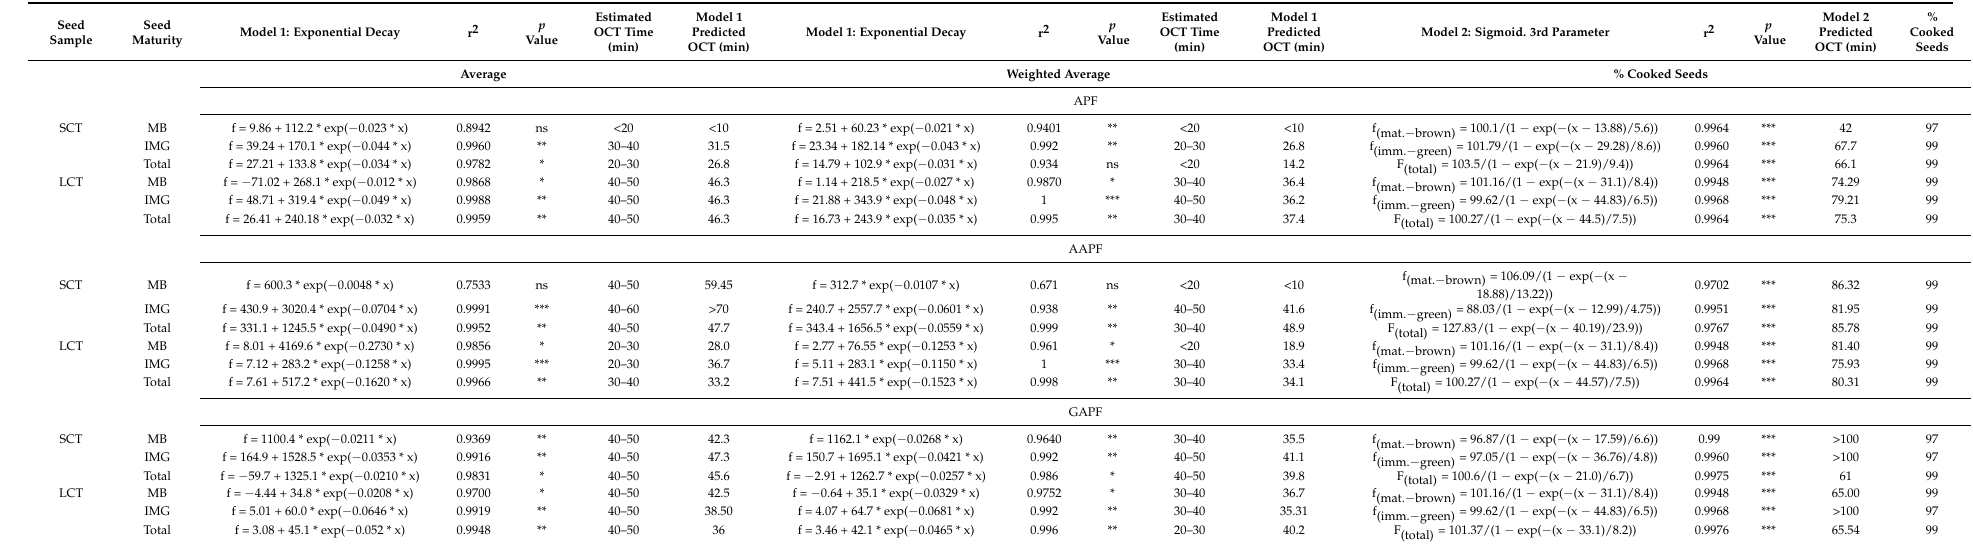
Table 4. Estimated range and predicted OCT based on the average and weighted average using the exponential decay model or based on the percentage of cooked seeds using the sigmoid model of MB, IMG, or total lentil seed samples (easy to cook—SCT, and hard to cook—LCT) for APF (absolute positive force), AAPF (area to absolute positive force), and GAPF (gradient to absolute positive force) during cooking at 100 ◦ C for 20–60